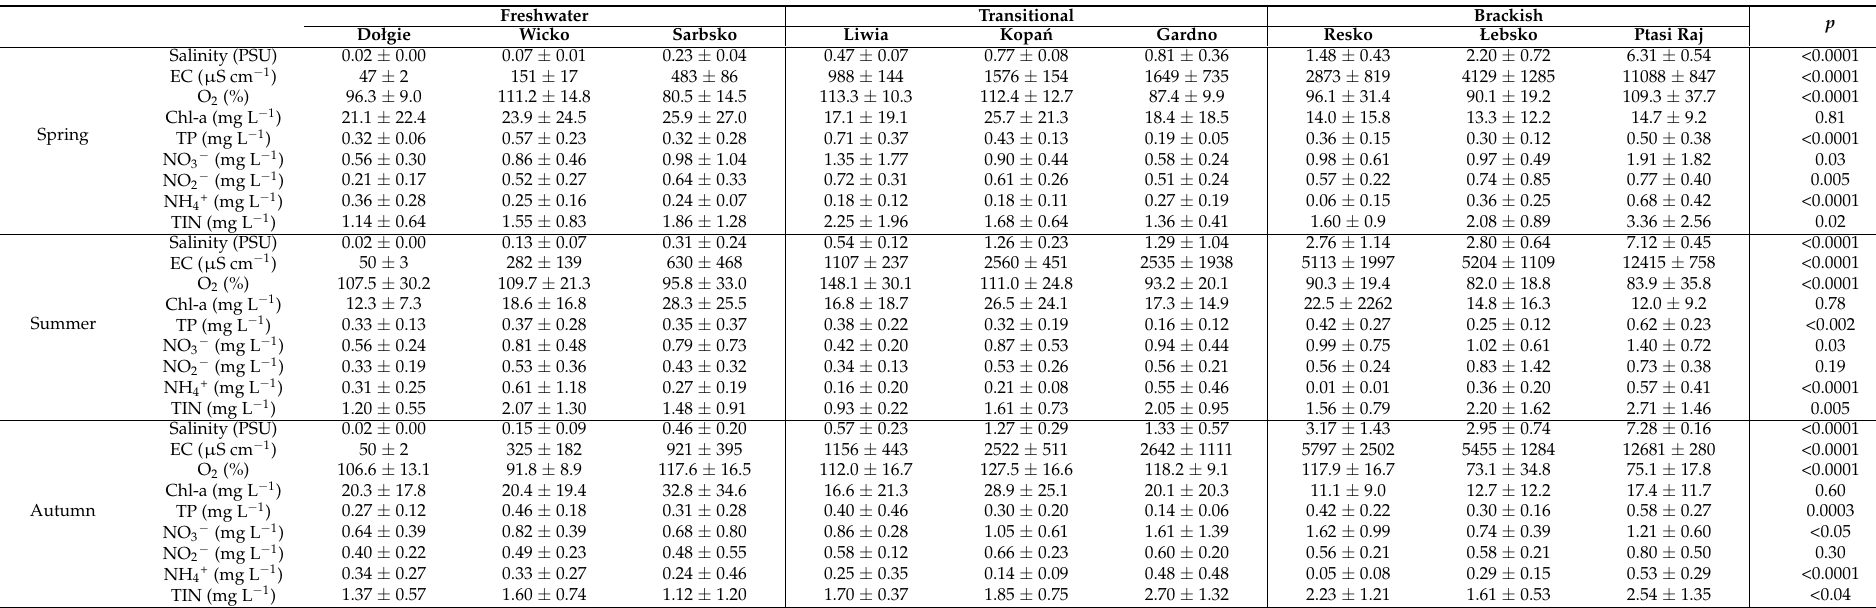
Table 1. Physico-chemical characteristics of water in Baltic coastal lakes. Values are means of samplings (2019–2020) grouped for seasons ± standard deviations and results of one-way ANOVA evaluating differences in results (Kruskal–Wallis test, significance level when p < 0.05). The specific conductivity (EC) value was related to salinity according to Wagner et al.